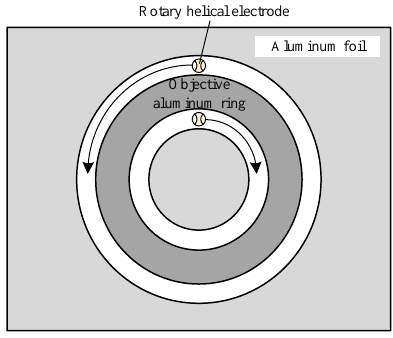
Figure 15. The feed trajectories of the outer circle and inner circle.